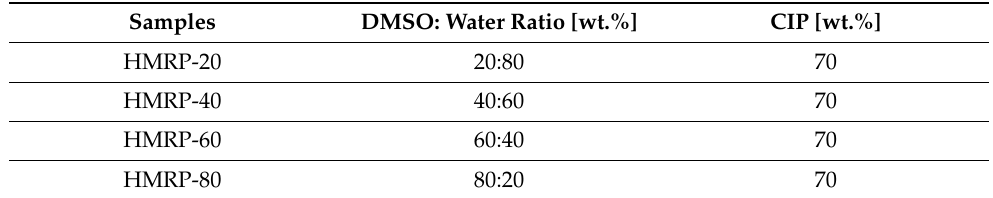
Table 1. Compositions of hydrogel MRP